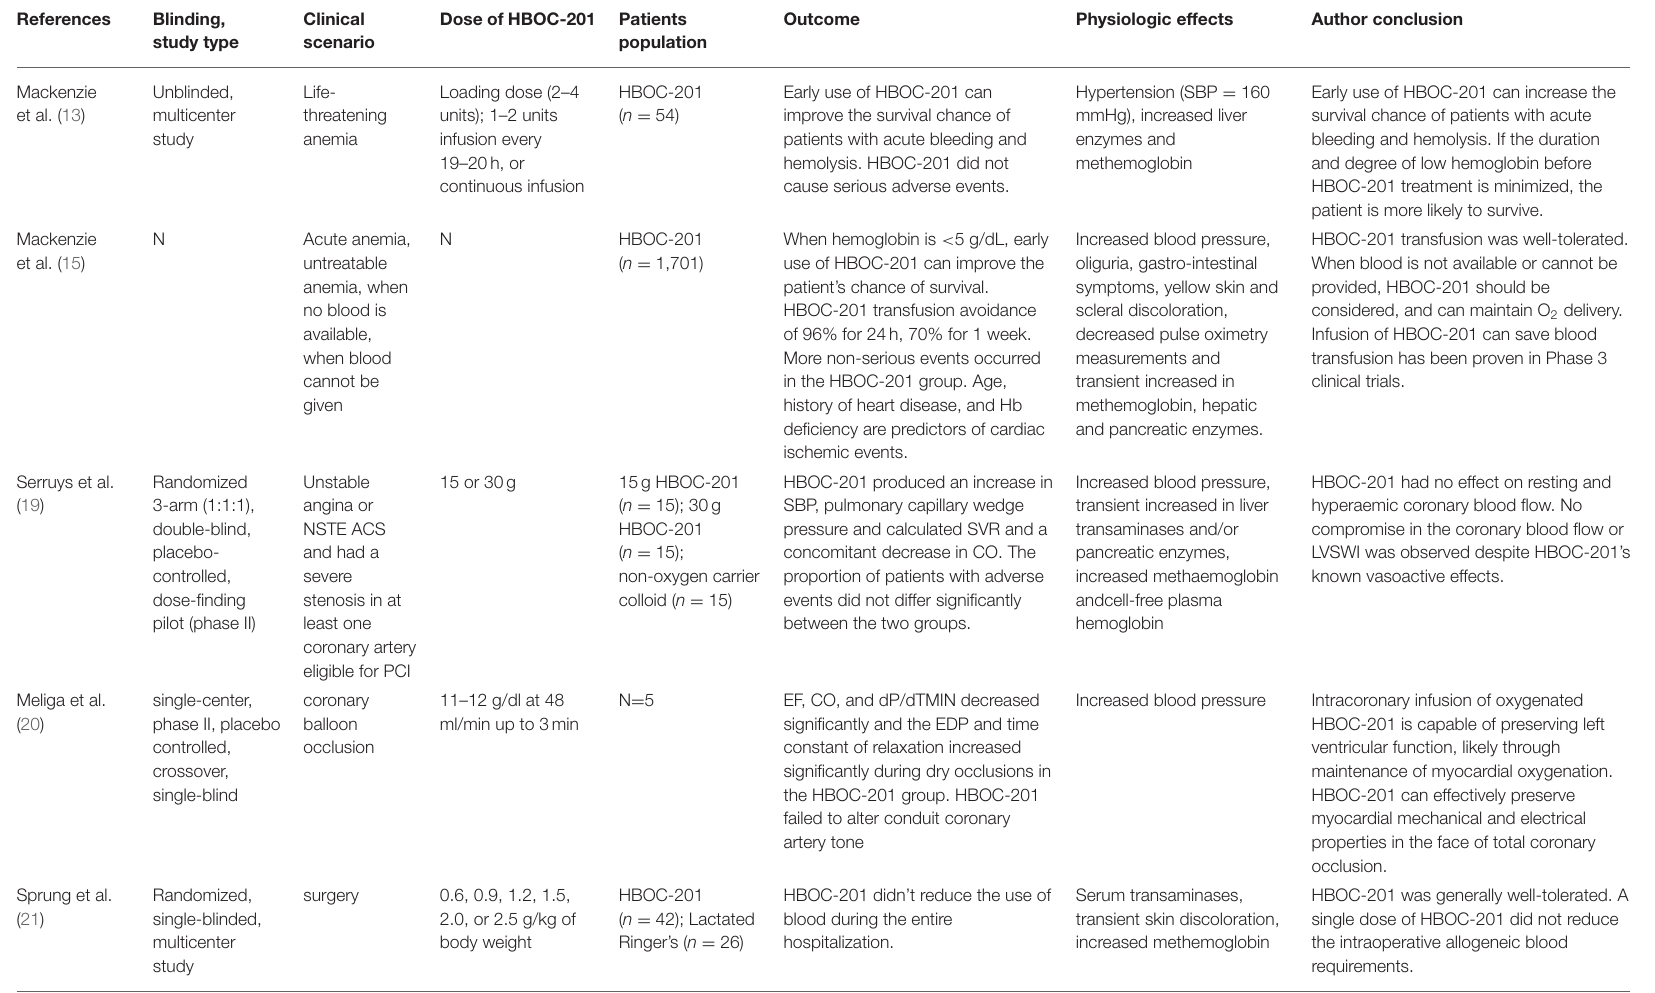
TABLE 1 | Summary of clinical trials of hemoglobin-based oxygen carrier-201